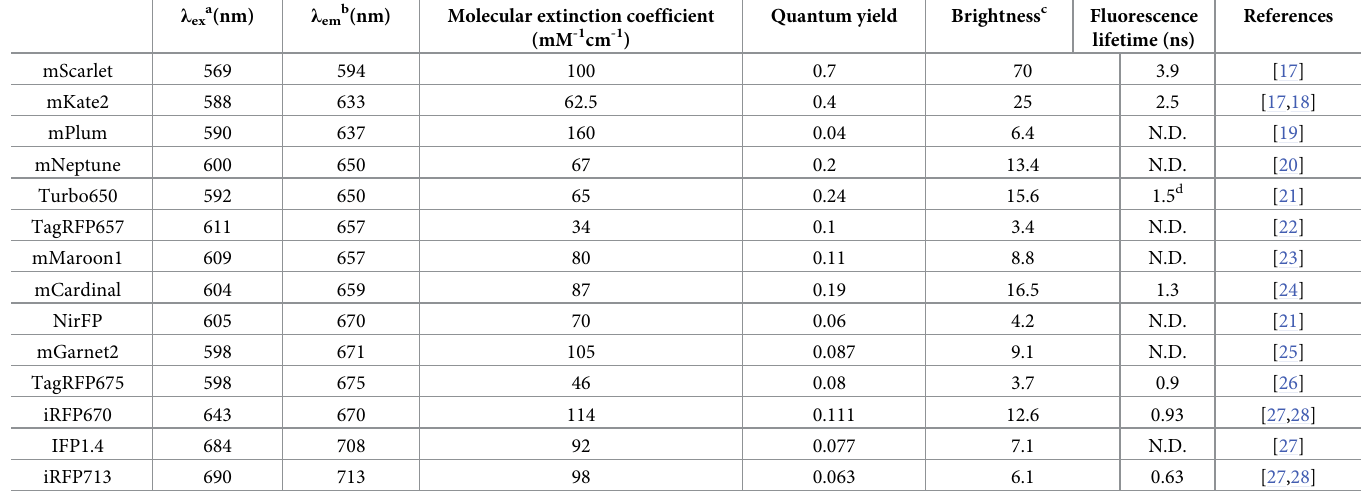
Table 1. Properties of fluorescent proteins in the far-red region of the spectrum. λ exa (nm) λ emb